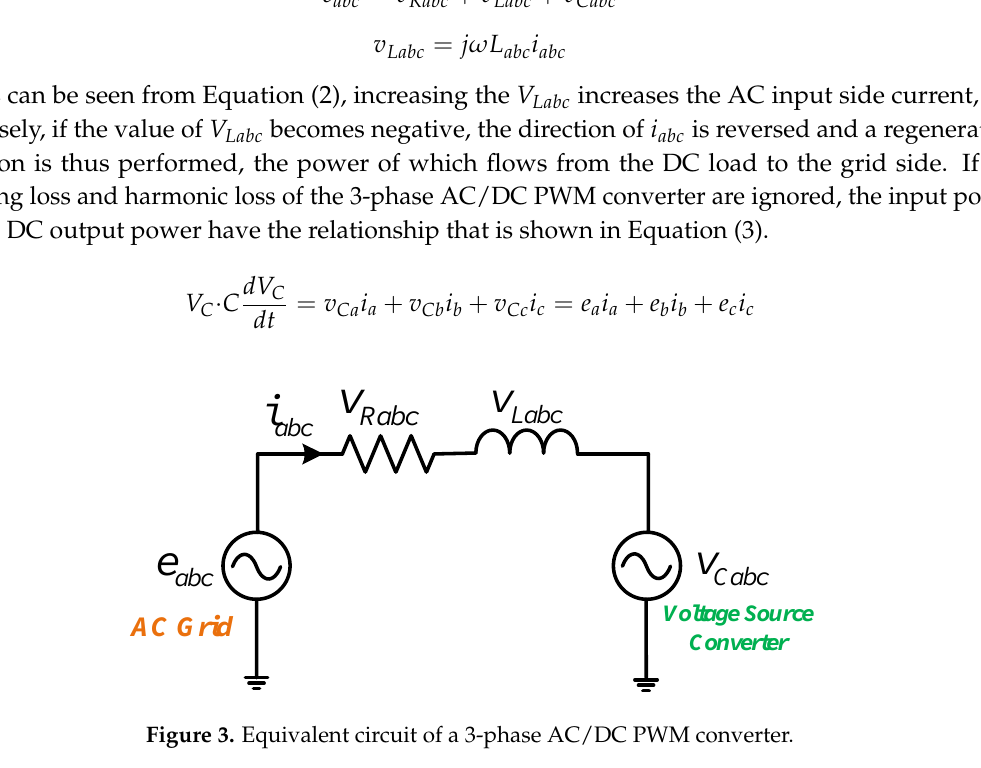
Figure 3. Equivalent circuit of a 3-phase AC/DC PWM converter.